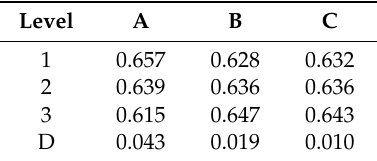
Table 5. Results of the range analysis of the maximum thickness di ff erence